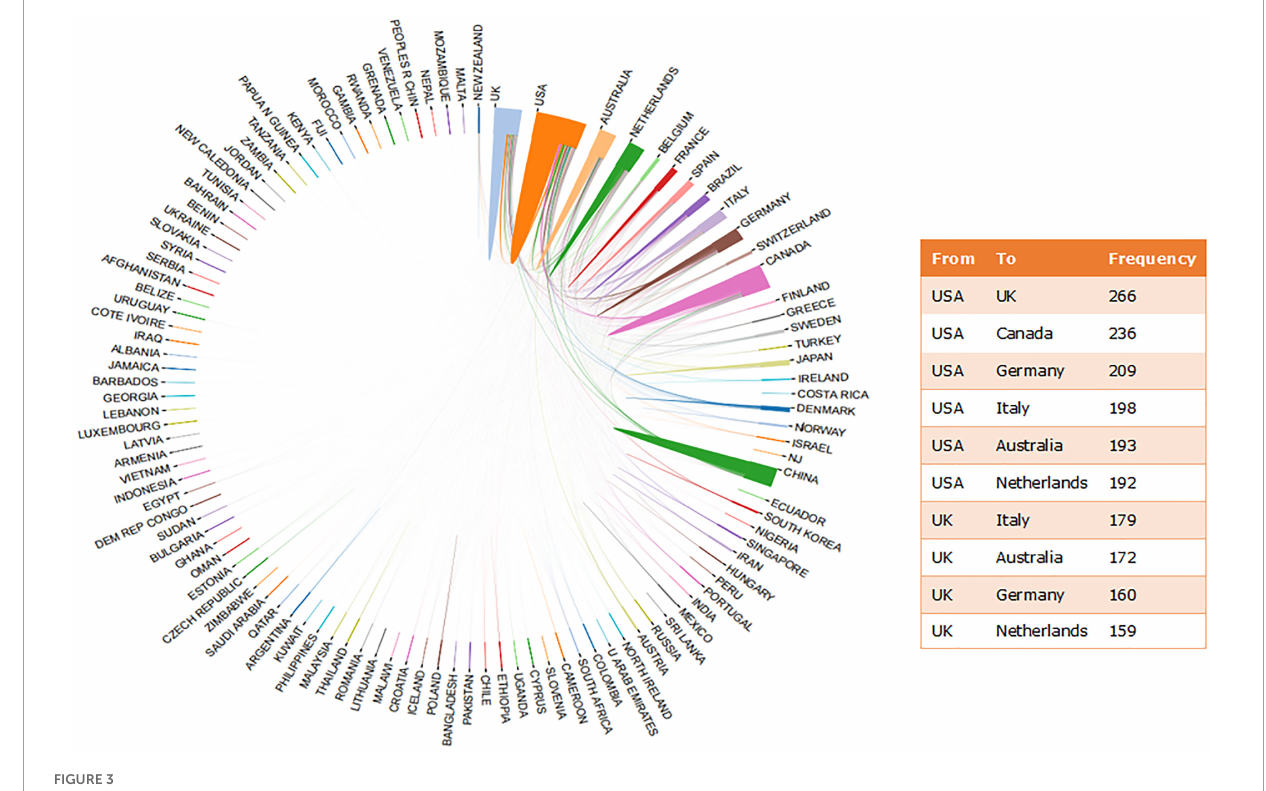
FIGURE3 Collaborative research between countries on MDD-related SR/MA.